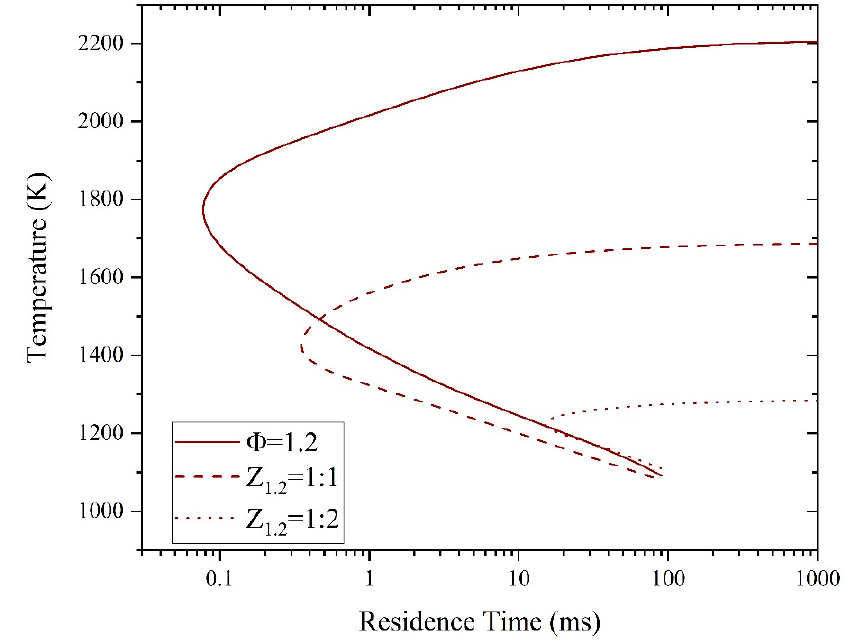
Figure 10. Comparison of C-curves of n -pentane at an equivalence ratio of 1.2 and air–light hydrocarbon mixing gas at mixing degree of 1 and 1/2, respectively.